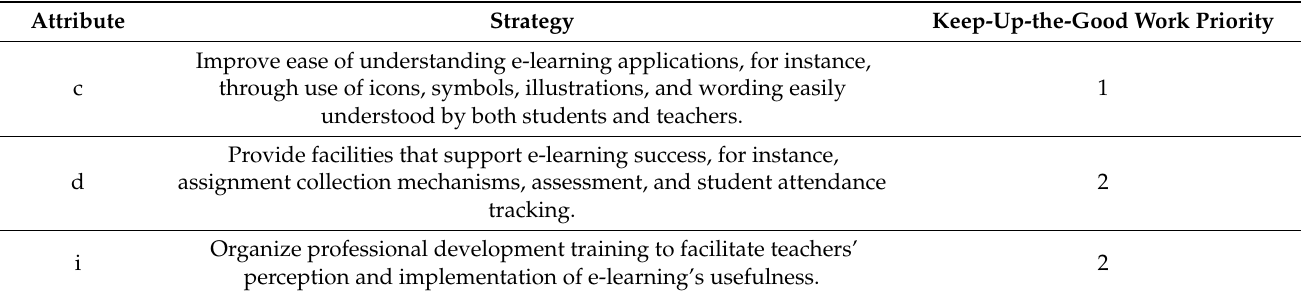
Table 7. Prioritized Recommendations for E-learning: Keep-Up-the-Good